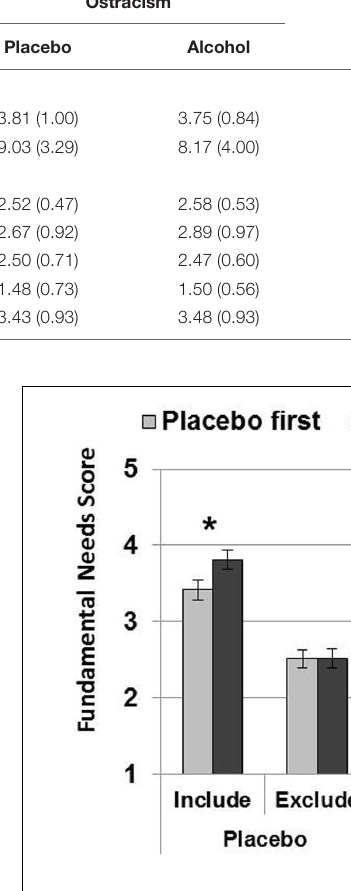
FIGURE 2 | Order effects analysis. Mean (SE) Fundamental Needs scores were lower after inclusion on placebo (when placebo was administered first), and lower after inclusion on alcohol (when alcohol was administered first). Thus, scores were always lower on the first testing session, but for inclusion only. Order effects did not influence fundamental need scores after exclusion, and the overall magnitude of ostracism on fundamental need scores were similar after alcohol and placebo. ( ∗ p <